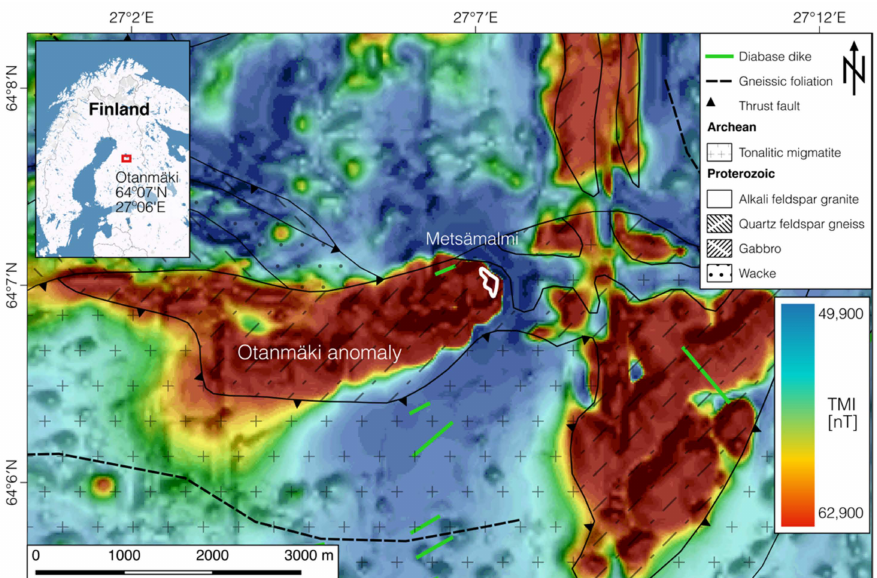
Figure 1. Hill-shaded total magnetic intensity (TMI) map of the Otanmäki area, central Finland, that is based on regional airborne surveys from GTK [31]. Main regional geologic structures and units are plotted on top. Our study area, the Metsämalmi outcrop, is marked as a white